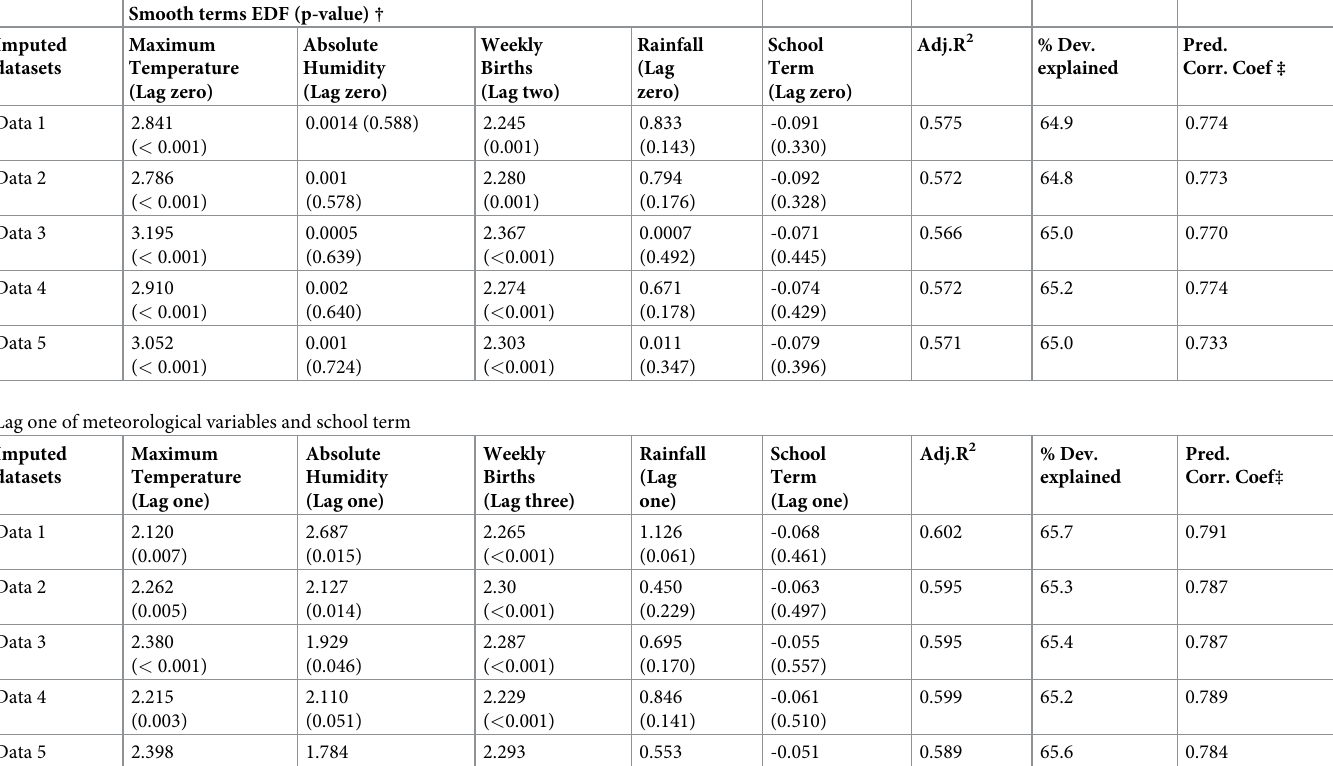
Table 1. Generalized additive negative binomial models with lags zero and one week of meteorological variables and lags two and three weeks of weekly number of births, respectively, in the 2002–2014